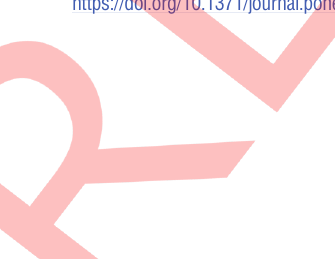
PLOS ONE | https://doi.org/10.1371/journal.pone.0249230 June 22,